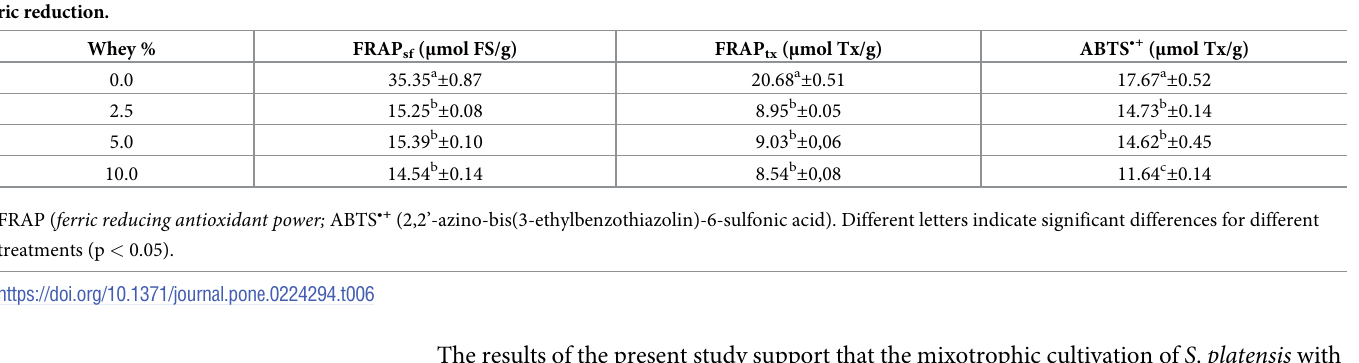
Table 6. Antioxidant activity of S . platensis by the ABST •+ (2,2’-azino-bis (3-ethylbenzothiazolin)-6-sulfonic acid) free radical scavenging method and by FRAP fer- ric reduction. Whey % 0.0